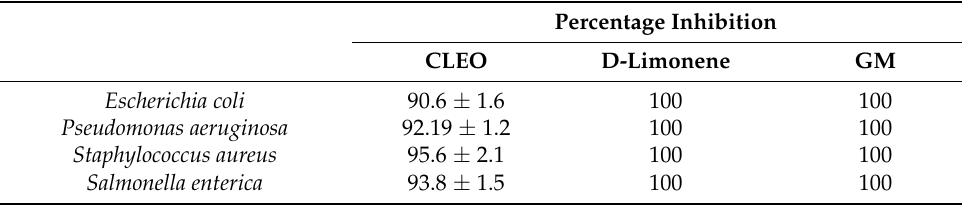
Table 6. The percentage inhibition of antibiofilm formation activity of the Citrus limetta (CLEO) essential oil and standard gentamicin (GM) against selected microbial strains (at 0.5